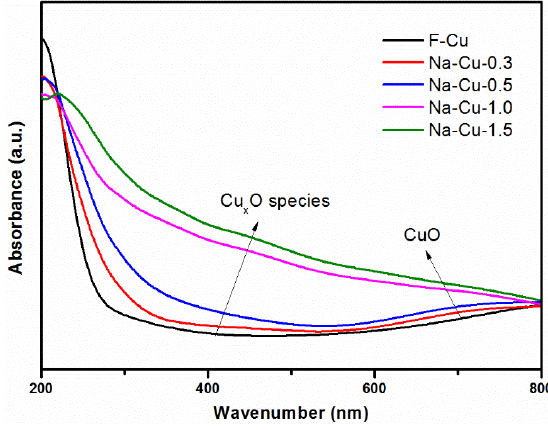
Figure 7. UV-Vis DRS results of fresh and Na-impregnated catalysts.